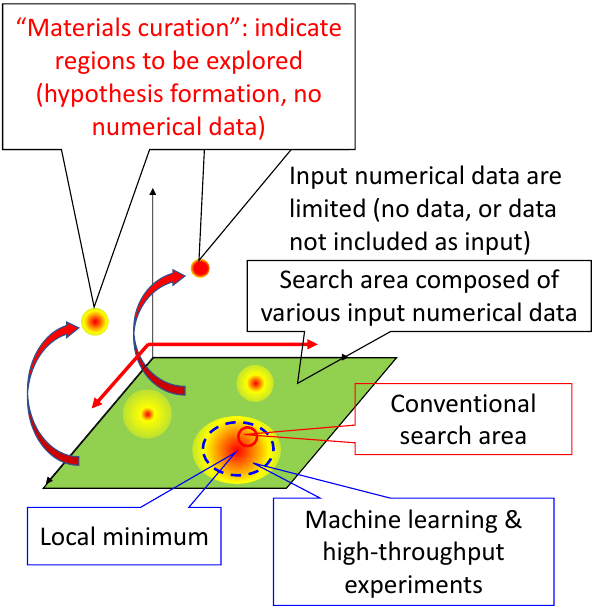
Figure 2. Schematic representation of search space with numerical input data (conventional or machine learning) and without numerical input data (materials curation).